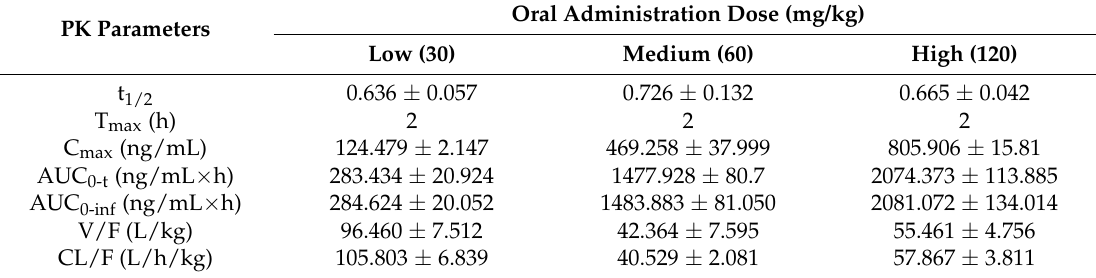
Figure 2. The concentration–time curve of GE after oral administration. The AA rats were treated with different concentrations of GE (30, 60 and 120 mg/kg) for 7 days. Samples were collected at the same time as the administration and once every 1 h for a total of 8 h. Values are presented as means ± SD ( n = 6). Table 3. Non-compartmental PK parameters of GE microdialysate levels obtained from articular cavities of AA rats: AUC (area under the curve), Cl/F (clearance of distribution), V/F (steady state volume of distribution), C max (extrapolated maximal concentration), T max (peak time) and t 1/2 (elimination half-life) after oral administration of GE (30, 60 and 120